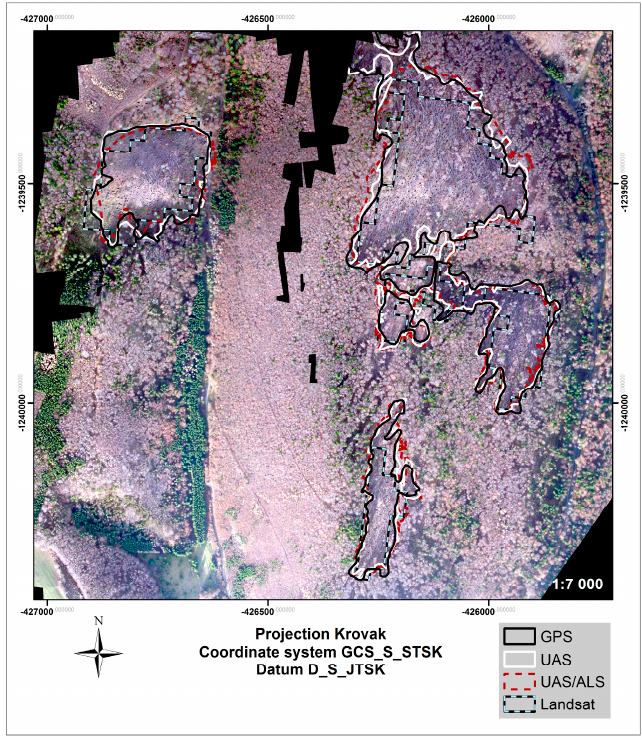
Figure 3. View of the windthrow areas determined by all four presented methods overlaid on the orthomosaic derived from UAS imagery.